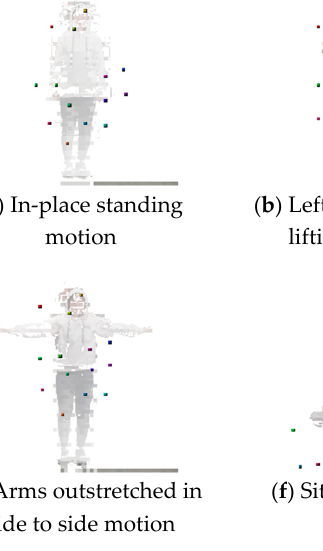
Figure A3. 3D landmarks generated when κ was 14.